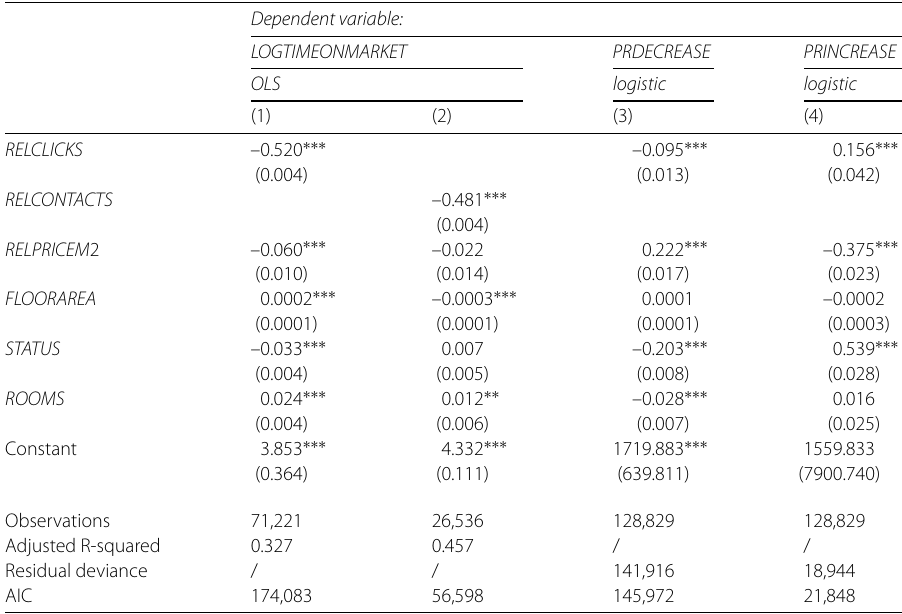
Table 1 Effect of online interest on time on market and chance of price revisions Dependentvariable: LOGTIMEONMARKET PRDECREASE PRINCREASE OLS logistic logistic